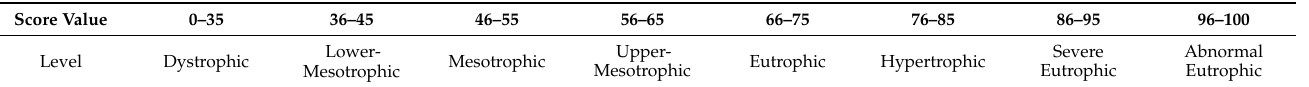
Table 2. The standard of grading and